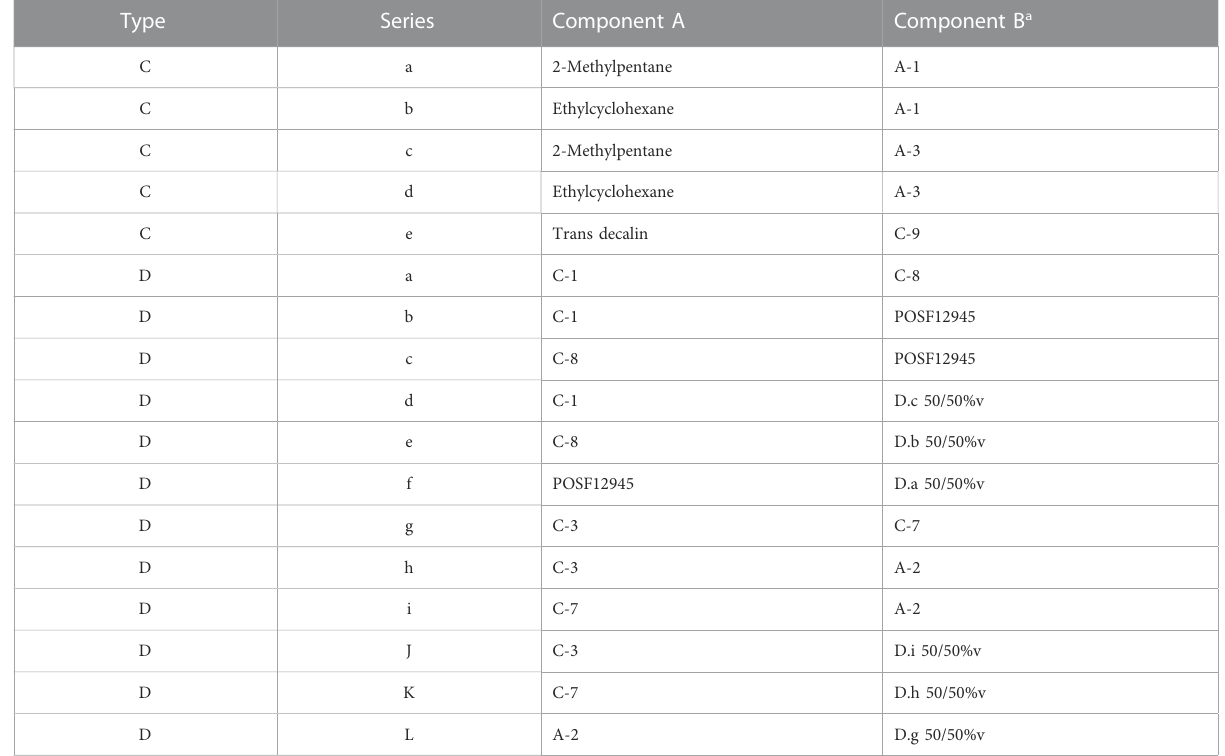
TABLE 6 Components of types C and D